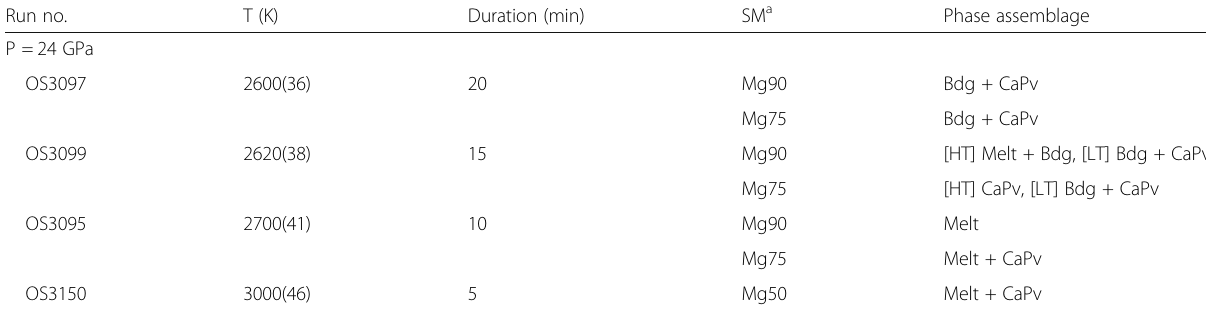
Table 2 Experimental summary Run no.